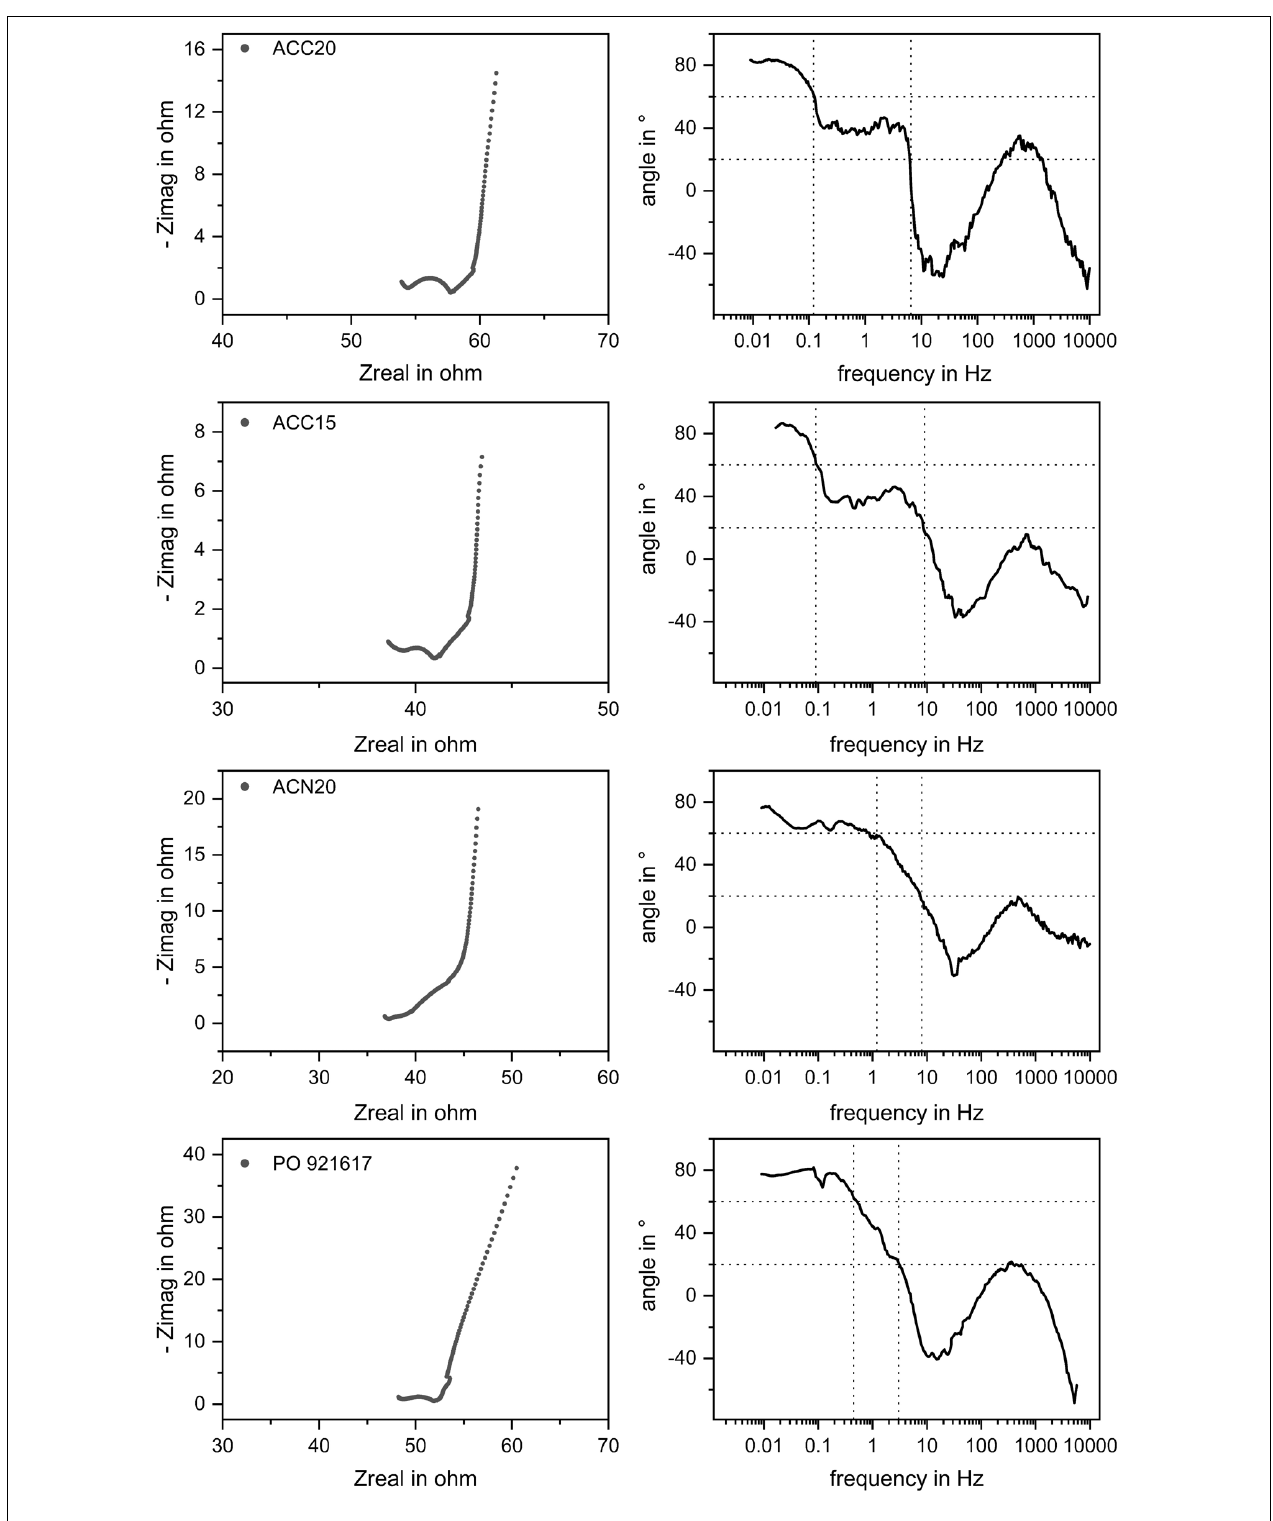
FIGURE 4 | Results of EIS measurements of the different electrode materials in a 50 mM NaCl solution. The Nyquist and the NIF plots are shown for all materials which are indicating the three characteristic parts in the Nyquist and NIF plots. Similar contact resistances can be seen whereas differences appear by looking at the slopes in the medium and low frequency parts leading to different material characteristics like specific capacitances and diffusion behaviors.